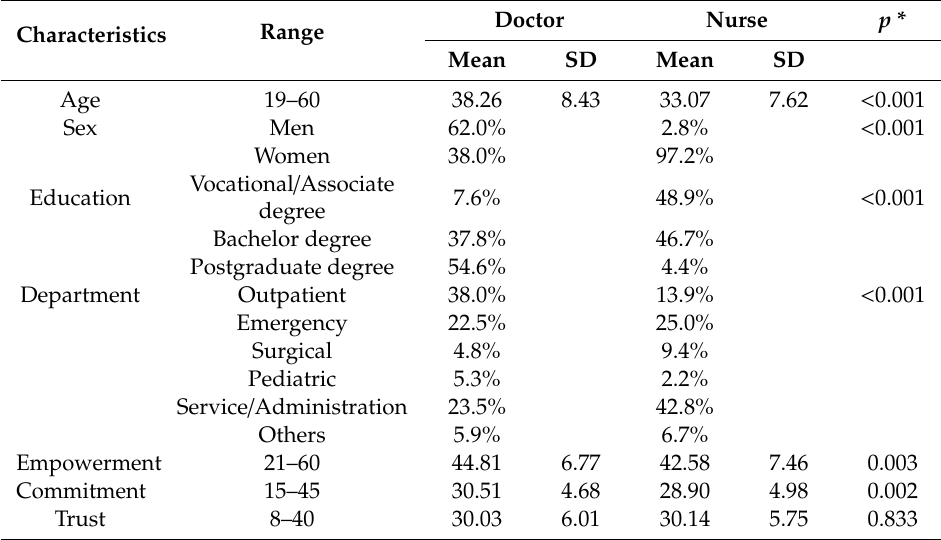
Table 1. Characteristics of doctor and nurse respondents.